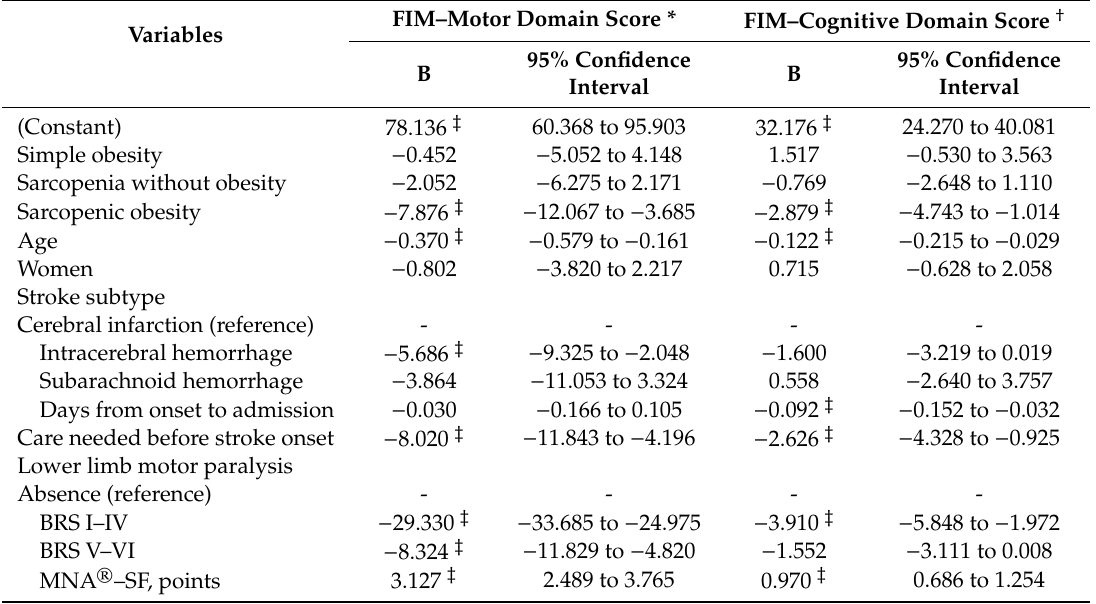
Table 3. Multivariate linear regression analysis for the FIM–motor domain score and FIM–cognitive domain score